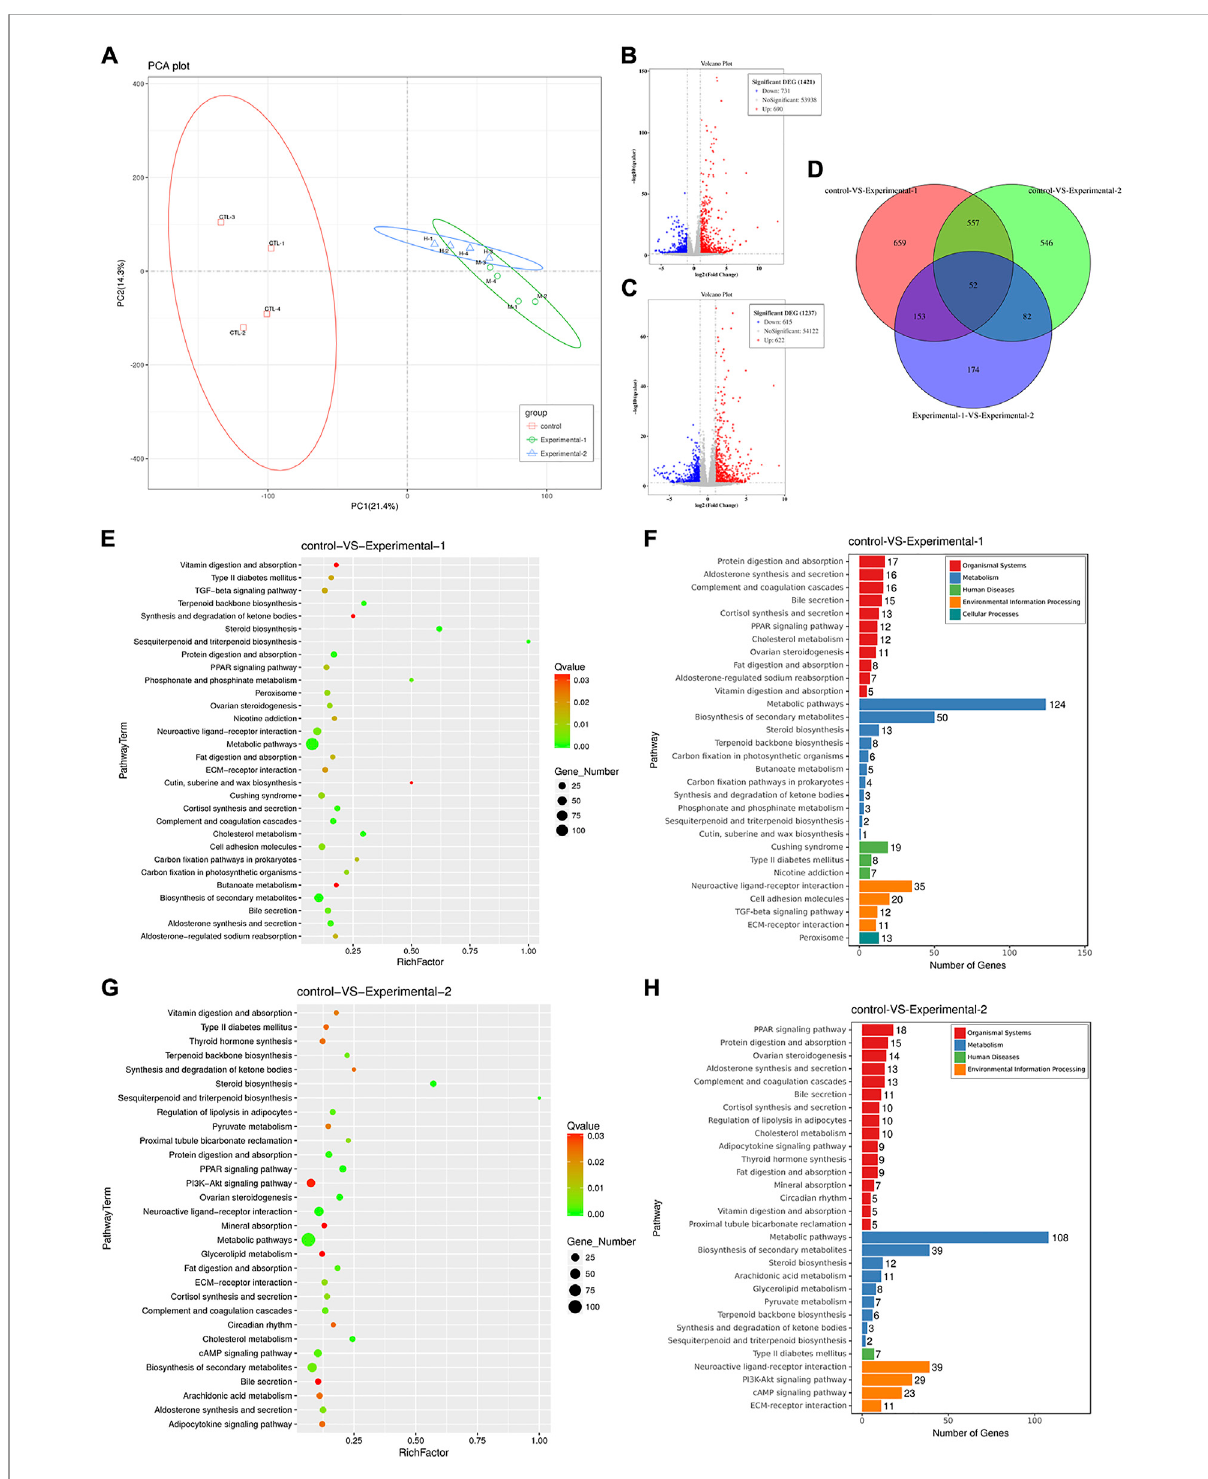
FIGURE 7 Analysis of the ovary transcriptome level after PMSG treatment. (A) Principal component analysis (PCA) was performed on the ovary (control, PMSGtreatmentfor2 daysor4 days),andtheRfunctionprcompwasusedtoanalyzethesamplesatthetranscriptomelevel.Thevolcanoplotshows differentiallyexpressedgenesofthreegroupsintheovarywithPMSGtreatmentfor2 days (B) and4 days (C) .Theredcirclerepresentsgenesthatare upregulated in gene expression, the blue circle represents genes that are downregulated in gene expression, and the gray circle represents insigni fi cant genes. (D) Venn plot shows the correlation of differential genes expressed among three groups. The bubble plot represented the